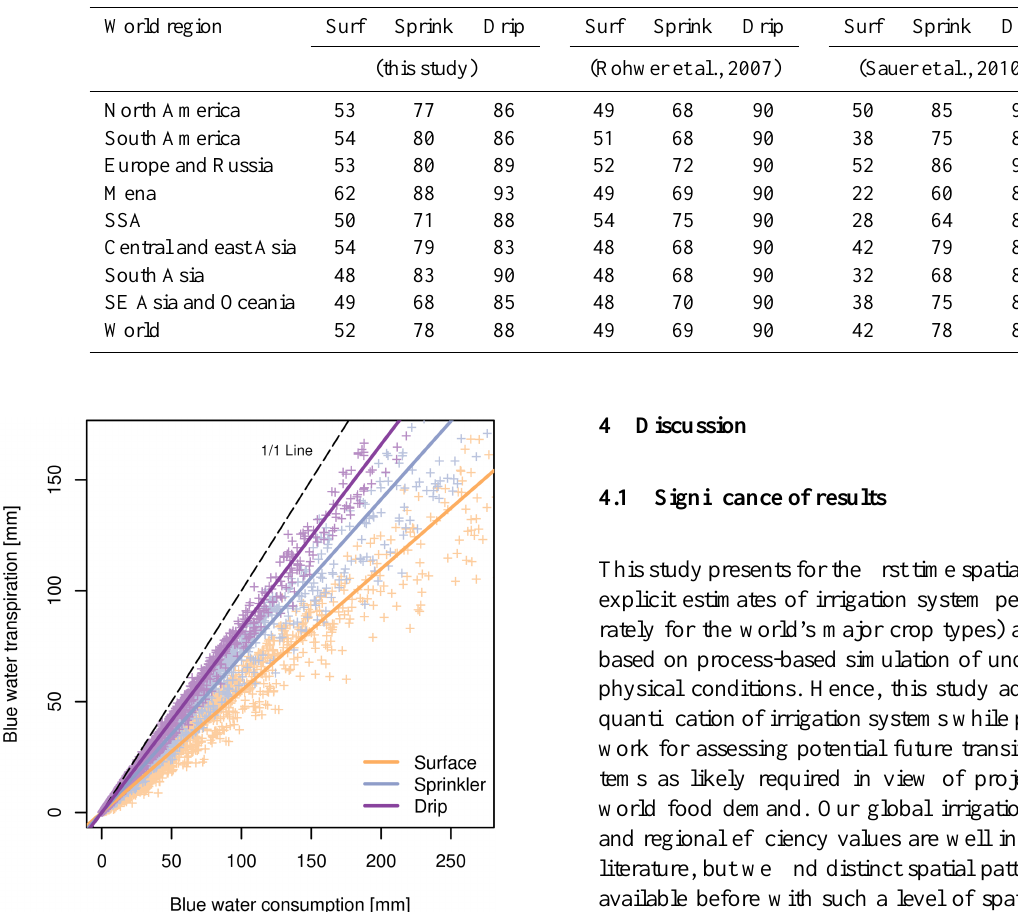
Table 5. Comparison of field application efficiencies (for reasons of comparison, we employ here the traditional definition: consumed per applied irrigation water) for major world regions compared with literature values in %. This study’s results are area-weighted averages, based on current distribution of irrigation systems (Fig. 3).